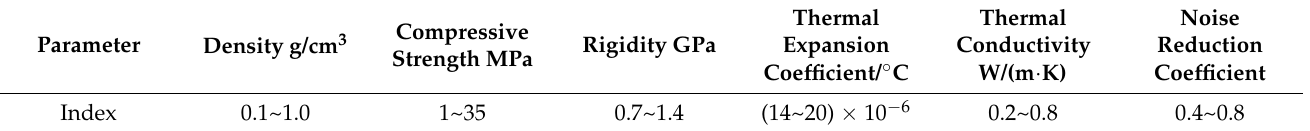
Table 1. Performance index of aluminum